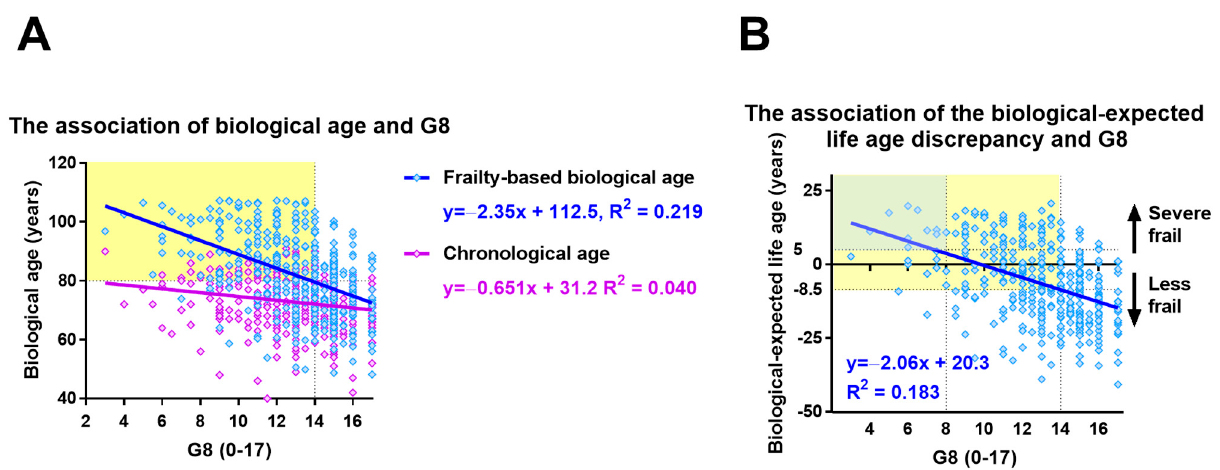
Figure 4. Exploratory outcomes. ( A ) Association of the chronological-biological age discrepancy with the geriatric 8 screening score (G8). The yellow part represents G8 ≤ 14 and biological age ≥ 80 years old. ( B ) Association of the biological-expected life age discrepancy with the G8. The yellow part represents G8 ≤ 14 and biological-expected life age ≥ − 8.5 years.